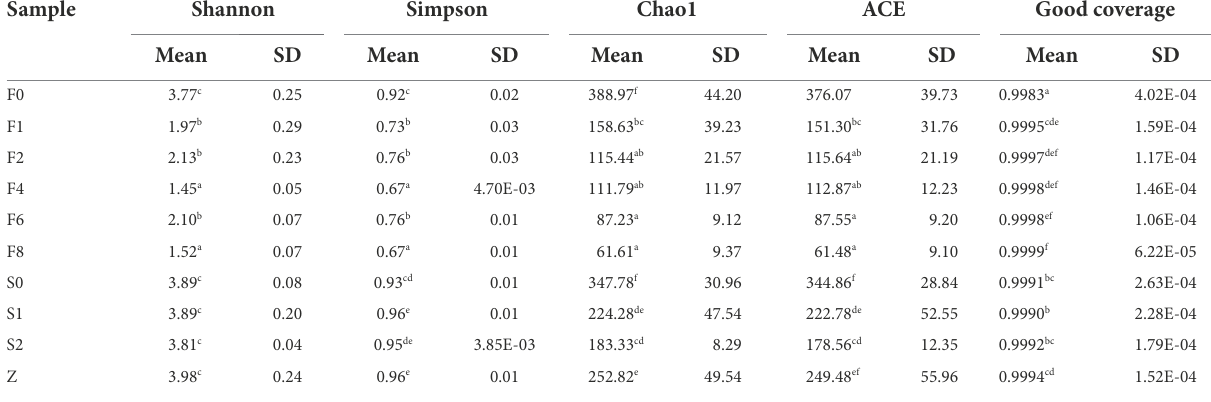
Values with different lowercase letters are significantly different ( p <